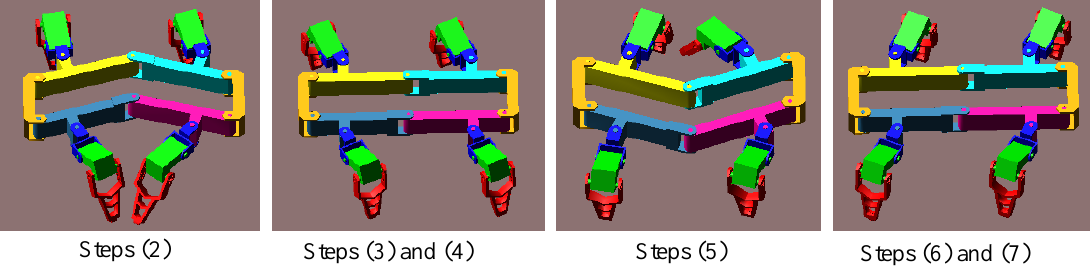
Figure 16. The animation of the MetaRobot I performing the continuous static periodic gait in Adams.